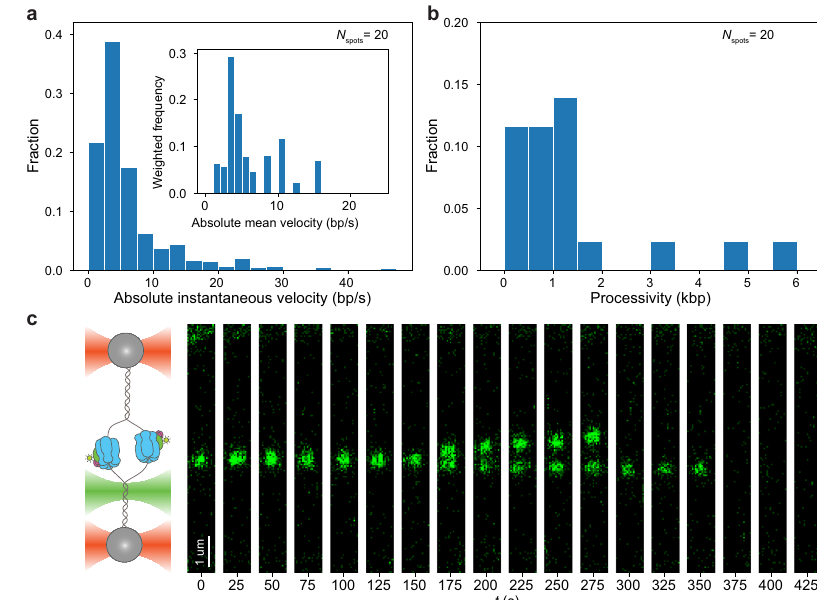
Fig. 3 | Analysis of CMG motor motion. a Distribution of absolute instantaneous velocities of unidirectionally moving CMG spots in the presence of ATP; (inset) Distribution of absolute mean velocities of unidirectionally moving CMG spots in the presence of ATP normalized by the length of each trace. b Distribution of